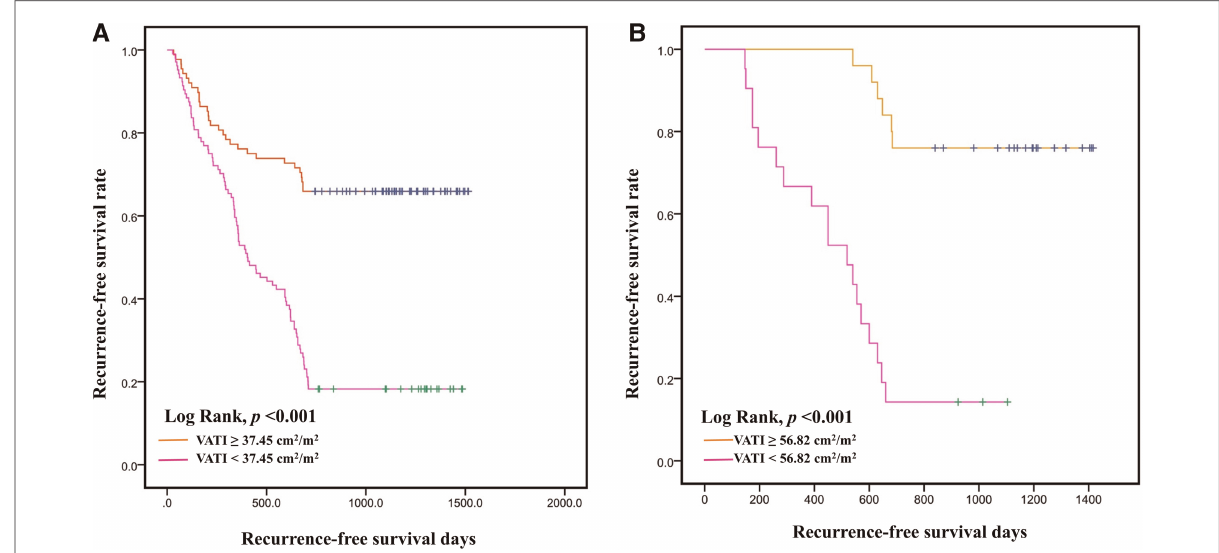
FIGURE 5 Kaplan – Meier curves for recurrence-free survival time. Recurrence-free survival with visceral adipose tissue index (VATI) ≥ 37.45 cm 2 /m 2 and <37.45 m 2 /m 2 in internal training cohort ( A ). Recurrence-free survival with visceral adipose tissue index (VATI) ≥ 56.82 cm 2 /m 2 and <56.82 cm 2 /m 2 in external validation cohort ( B